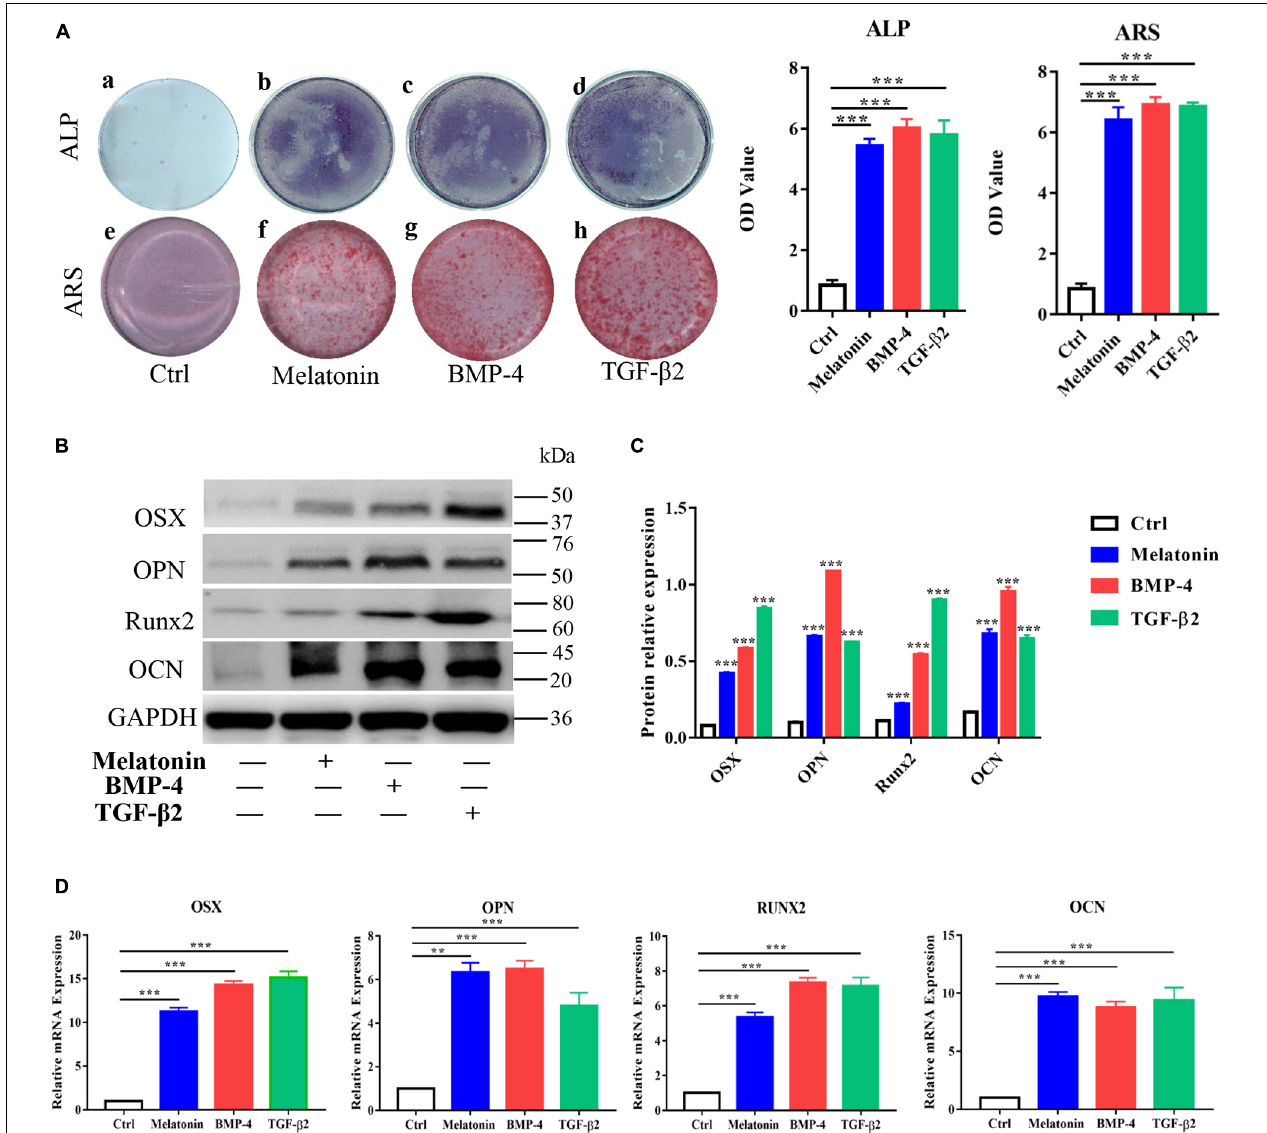
FIGURE 6 | Effect of melatonin on osteogenesis of EndMT-induced RAOECs. Primary RAOECs were induced to undergo EndMT for 2 weeks and further induced to undergo osteogenic differentiation for another 3 weeks. (A) Cells in the experimental and control groups were stained with ALP and Alizarin Red. (B) Western blot with quantification analysis (C,D) quantitative RT-PCR both showed that melatonin enhanced the expression of the osteogenic markers OSX, OPN, Runx2, and OCN. The data represent the mean ± SD. ** P < 0.01, *** P < 0.001 versus the control